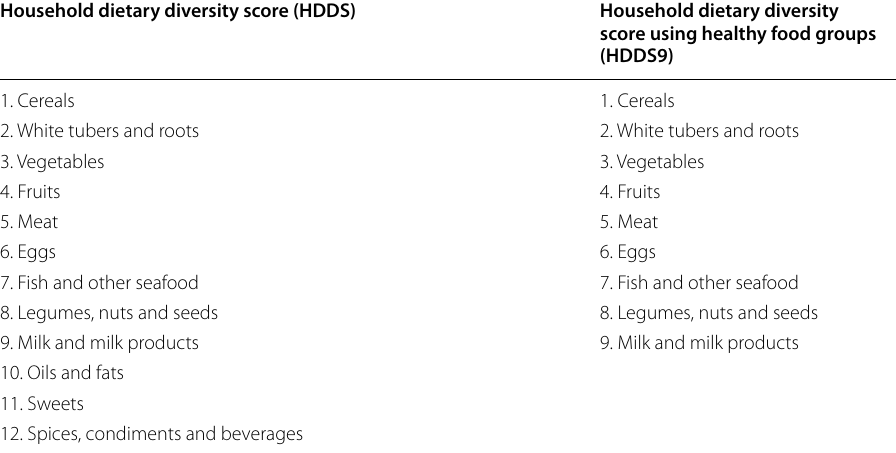
Table 2 Food groups included in household dietary diversity score. Source : Combined from Kennedy and Ballard